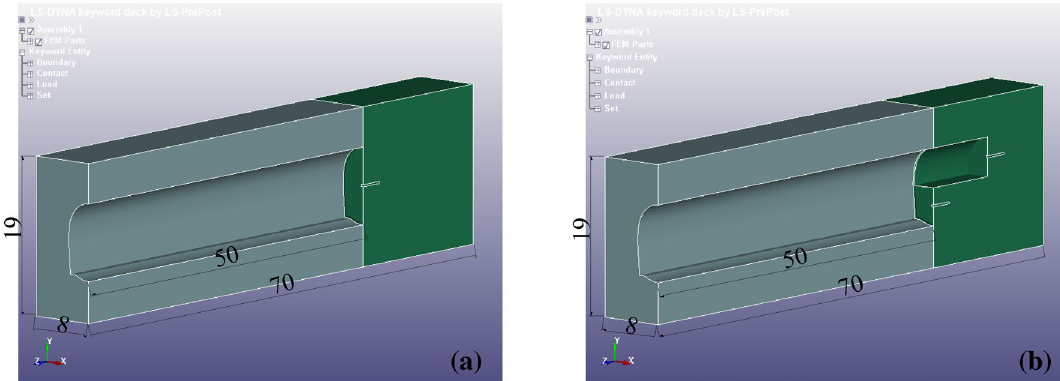
Figure 5. Tunnel numerical model: ( a ) Full section model. ( b ) Step model.